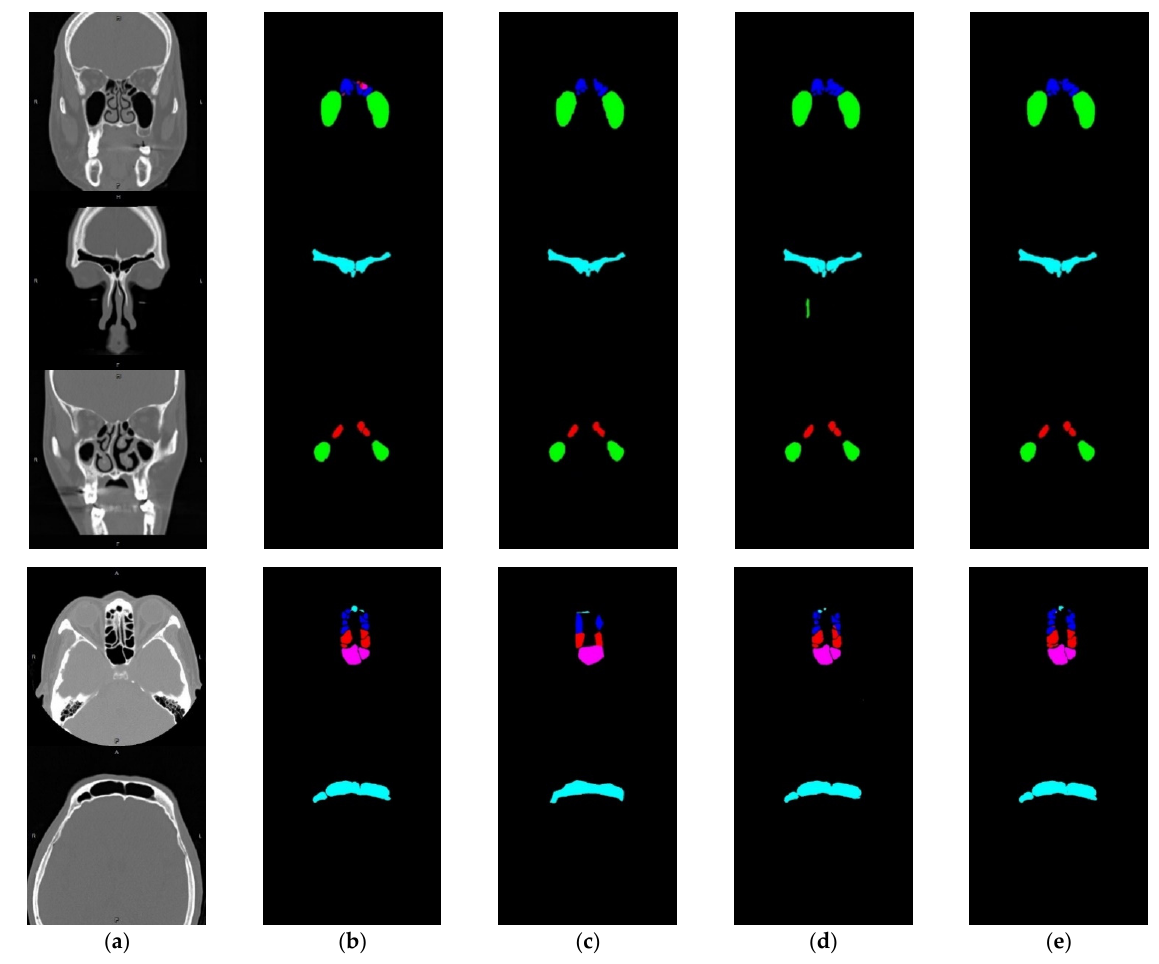
Figure 15. Comparison diagram of prediction results of various semantic segmentation models. ( a